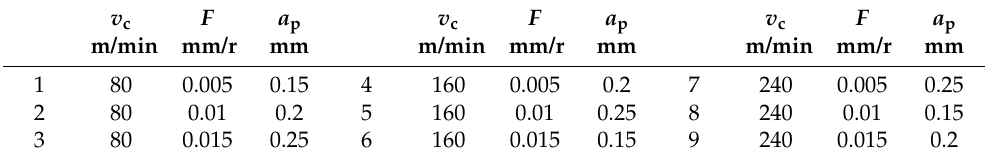
Table 2. Orthogonal experimental L 9 v